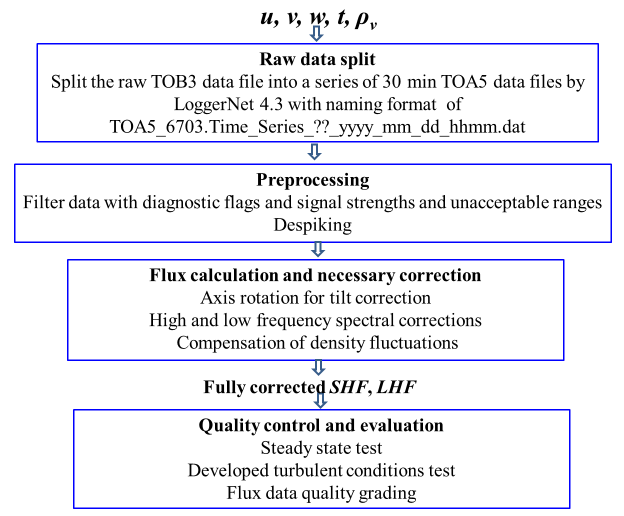
Figure 3. EC turbulence data processing and quality control flow